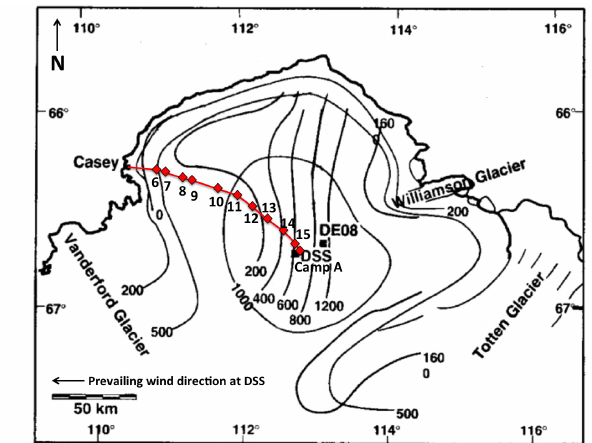
Figure 1. Map of Law Dome with contours of elevation (ma.s.l.) and accumulation (kgm − 2 a − 1 ). The red line indicates the traverse route from Casey station to Camp A located near the Law Dome Summit. Red diamonds indicate the Law Dome Traverse (LDT) surface snow sampling stations. DSS1516, DSS1213 and DSS0506 sampling sites are all in the vicinity of Camp